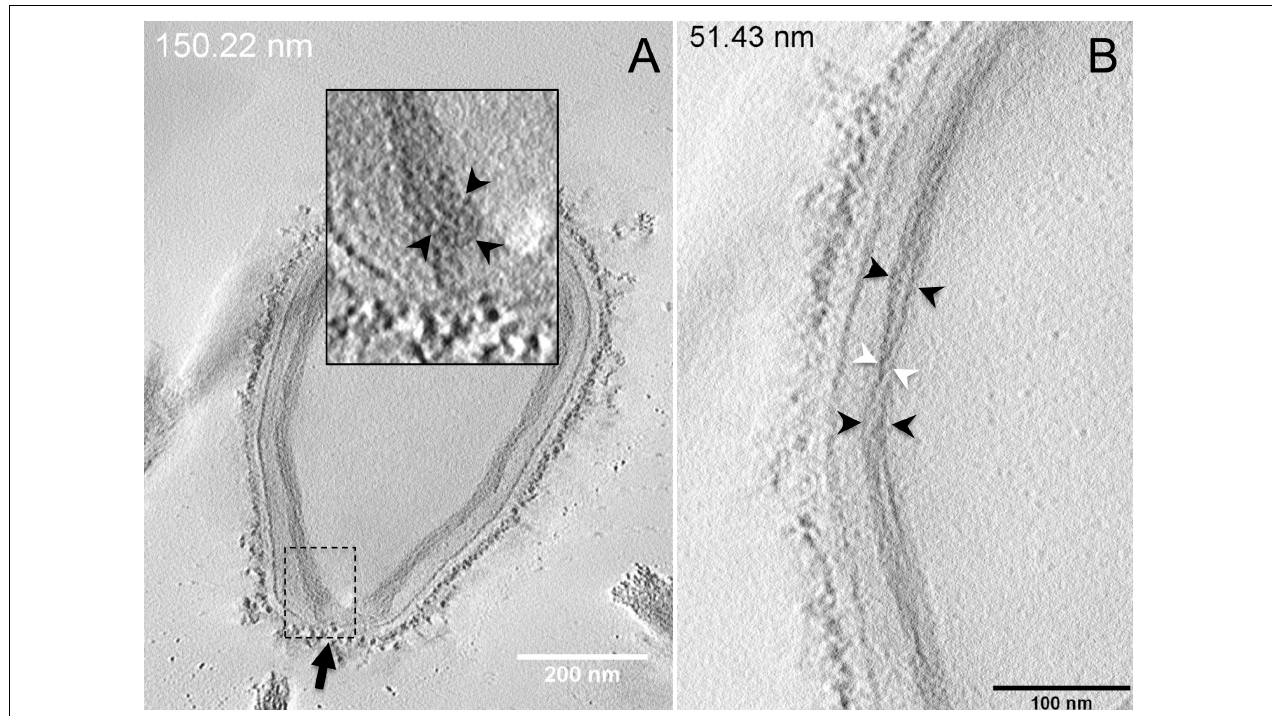
FIGURE 4 | Electron tomography of P. massiliensis particles from Movies 5 and 6 . (A) Single plane in the tomogram from Movie 5 showing a Pandoravirus particle with its ostiole (black arrow). The magnified boxed region depicts a U-shaped thick tubule (black arrowheads) from the inner-most layer. (B) Single plane in Movie 6 from the zoomed-in tomogram from Movie 5 showing the helical structural arrangement of the two thick tubules (arrowheads) composing the inner-most layer of Pandoravirus particles with distant tubules (black arrowheads) or crossed tubules (white